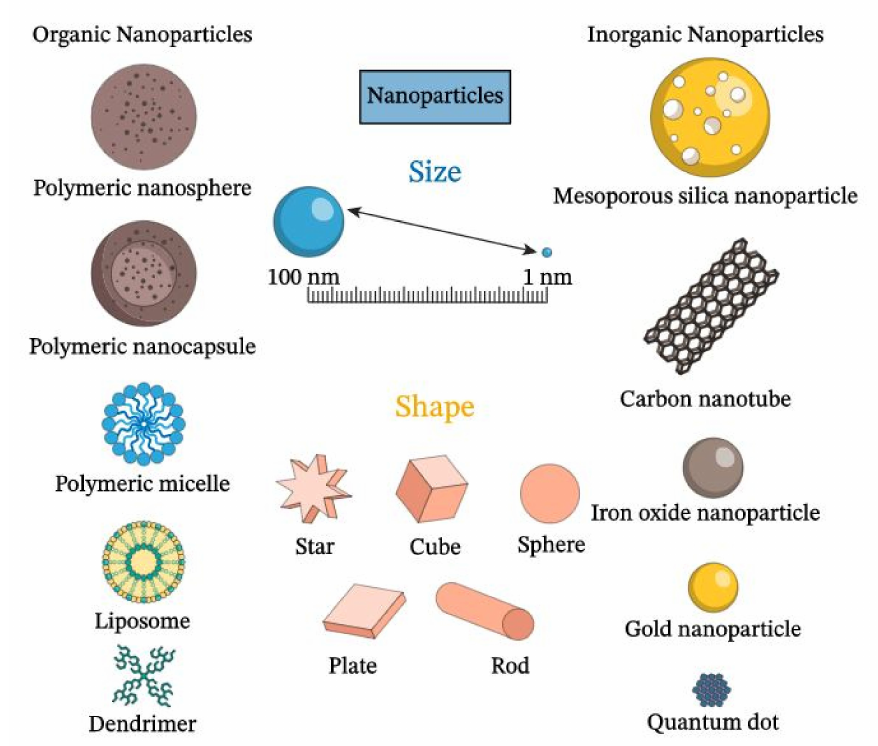
Figure 2. Types and shapes of nanoparticles. (Downloaded from https://www.nagwa.com/en/ explainers/640142370207/, accessed on 7 November